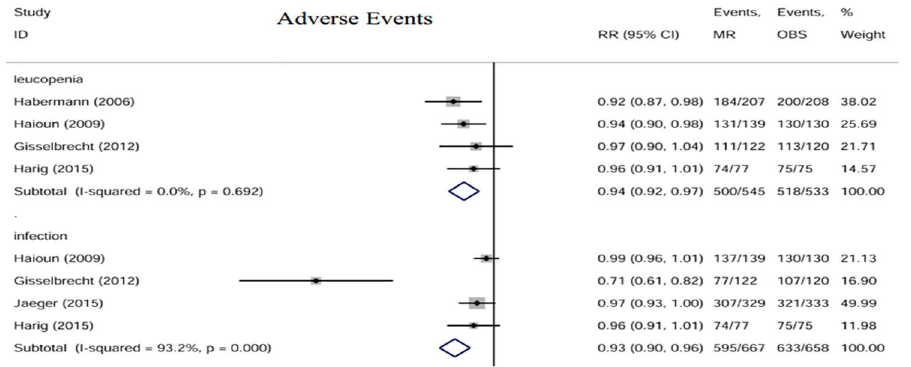
Fig 6. Forest plot of the RRs of main adverseevents. The size of the squaresreflects each study’s relative weight, and the diamond( ^ ) representsthe aggregateRR and 95% CI. MR, rituximab maintenance; OBS,